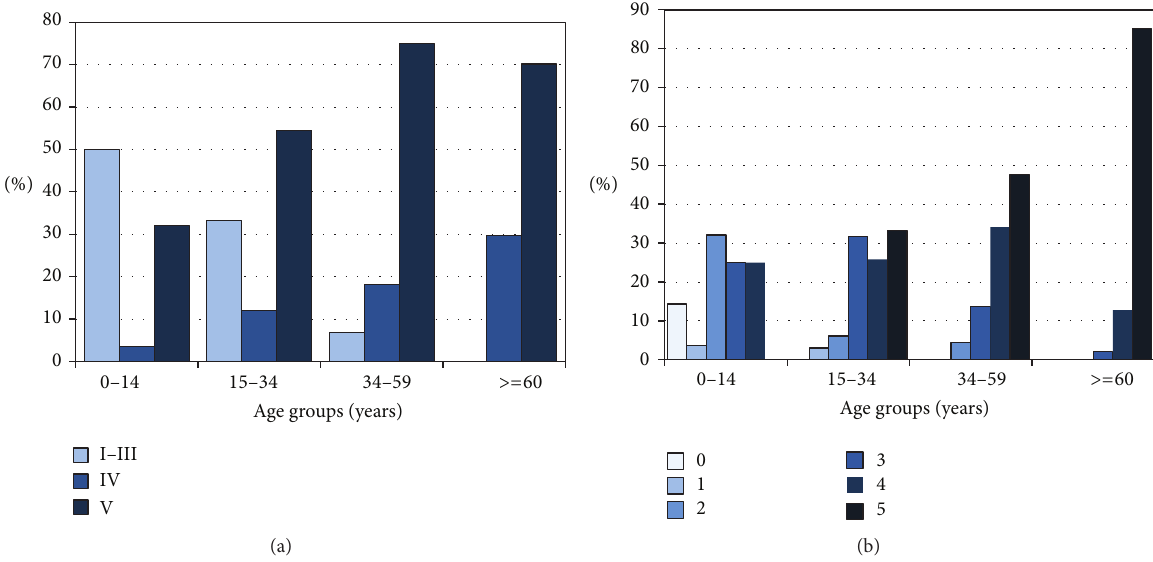
Figure 2: (a) Atherosclerosis severity (AHA pathological classification) in at least one of the five studied arterial territories (intracranial, carotid, coronary, renal, and aorta) according to age. (b) Number of atherosclerotic arterial territories (intracranial, carotid, coronary, renal, and aorta) according to